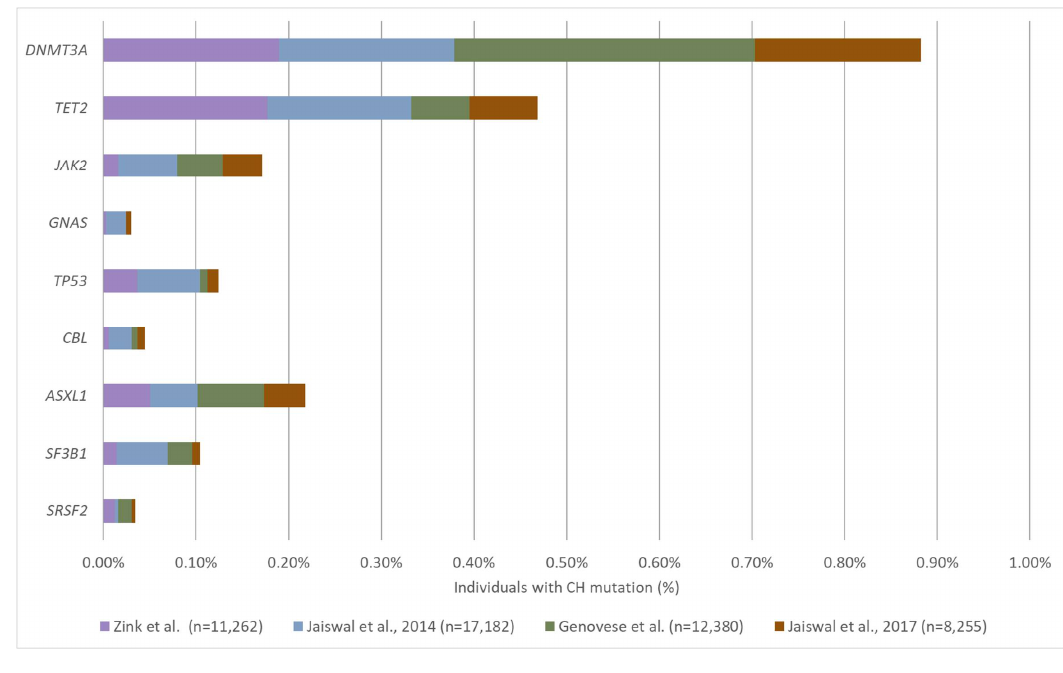
Figure 1. Comparison of the limit of detection and the reported CH prevalence at age 70 by different sequencing methods. Whole-genome sequencing (WGS), sequences the entire genome at a low sequencing depth resulting in a limit of detection of 7%. Whole-exome sequencing (WES) only detects coding variants but can achieve a greater depth of sequencing than WGS. Targeted sequencing specifies a selection of genomic locations and it can achieve greater sequencing depth with a lower limit of detection than either WGS or WES.